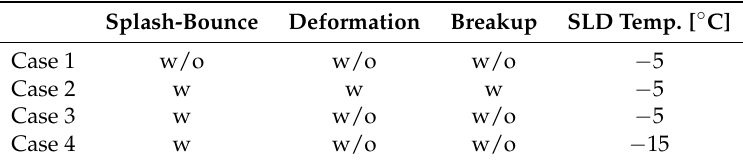
Table 4. Computational conditions for axial fan